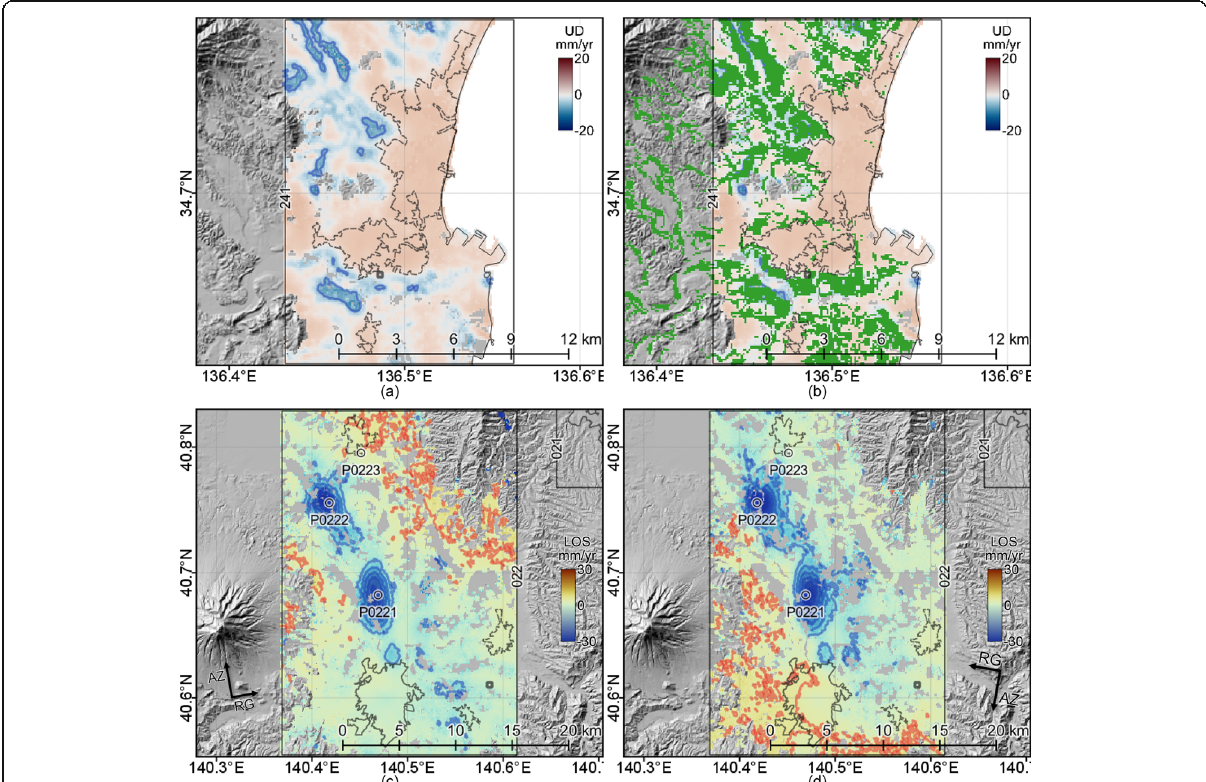
Fig. 16 a Vertical deformation velocities in Tsu (ID: 241). The black lines denote the outlines of the DID. The interval of the blue (subsidence) contour lines is 5 mm/year without the 0 mm/year lines. The black square denotes the reference point. b Shows the same information as (a) but overlaid with the green rice paddy fields. c Unmasked LOS deformation velocities from the ascending 141A_04925_131313 in Hirosaki (ID: 022). The interval of the red (LOS shortening) and blue (LOS extension) contour lines is 5 mm/year without the 0 mm/year lines. d Unmasked LOS deformation velocities from the descending